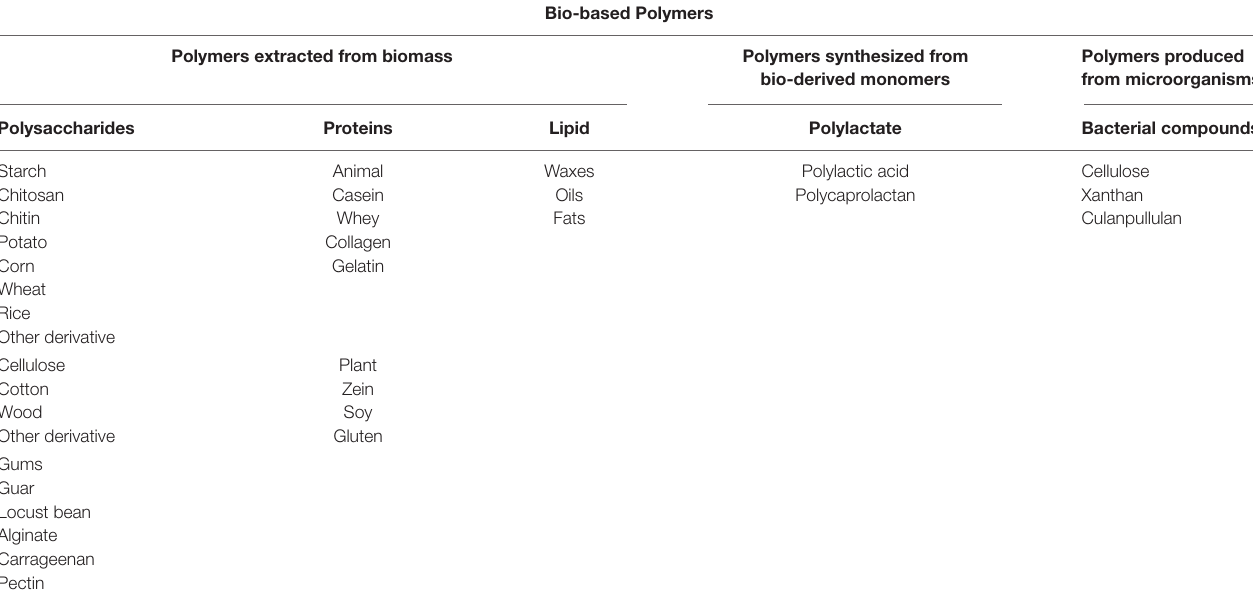
TABLE 3 | Three category of bio-based polymers. Polymers extracted from biomass Polymers synthesized from